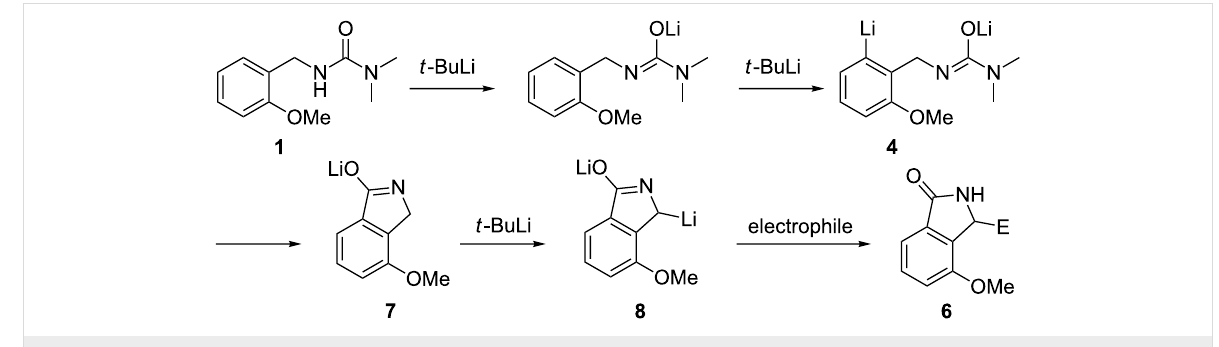
Scheme 4: A possible mechanism for the formation of 6 .